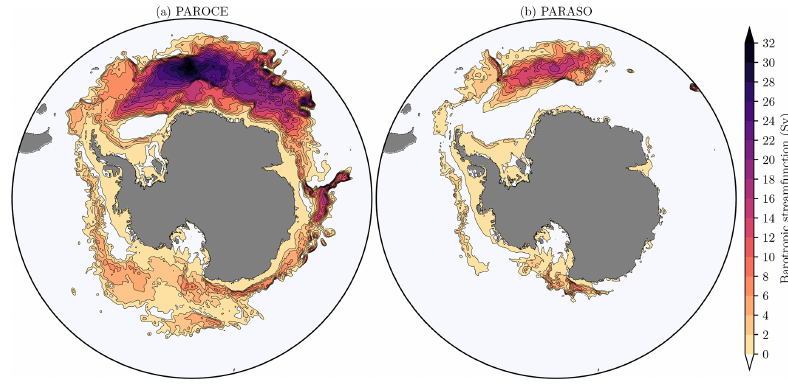
Figure A6. Barotropic streamfunction for (a) PAROCE and (b) PARASO, averaged over 2001 (second simulated year), in Sv (1Sv = 10 6 m 3 s − 1 ). The streamfunction has been set to zero over Antarctica. Positive values indicate clockwise circulation. Negative values are not represented.